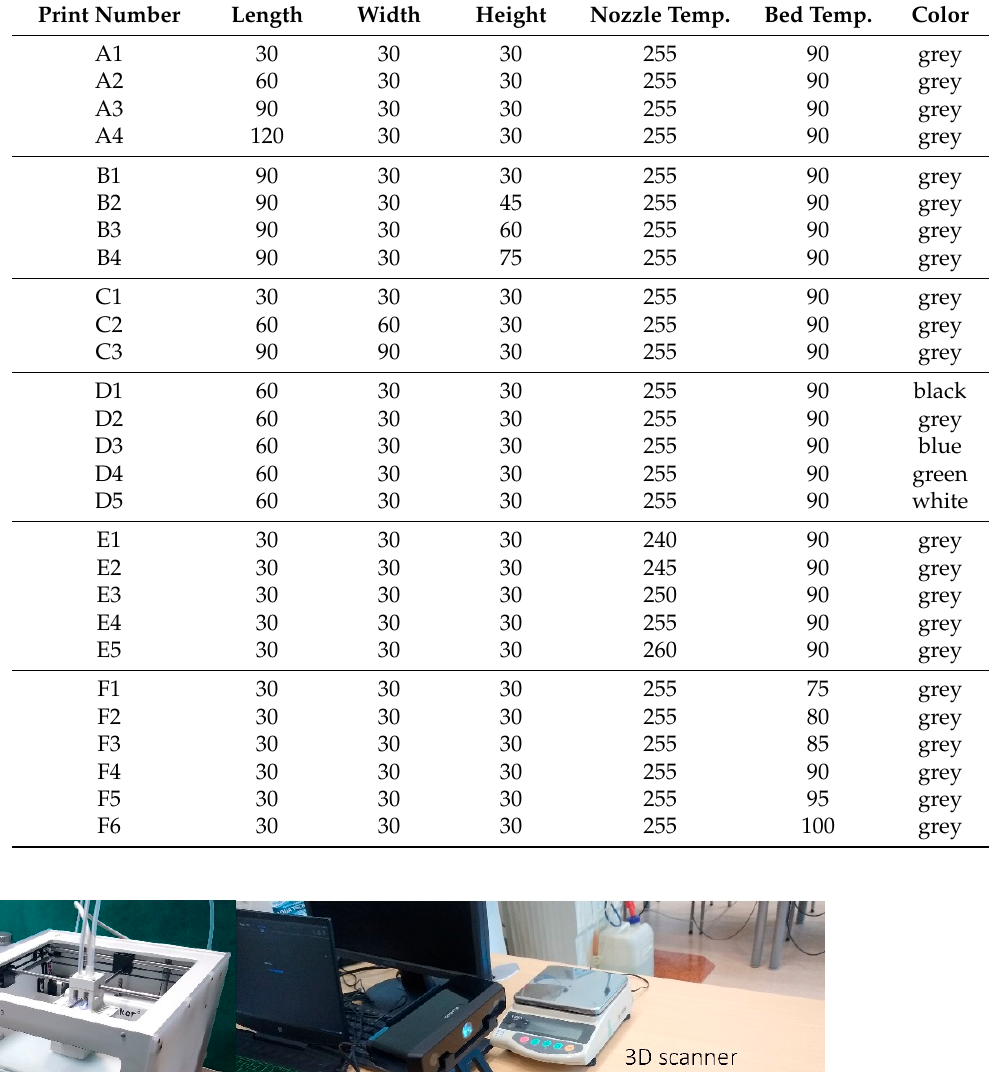
Table 2. Specification of printouts. Group A changes length, group B changes height, group C surface area, group D color, E nozzle temperature, and F bed temperature.